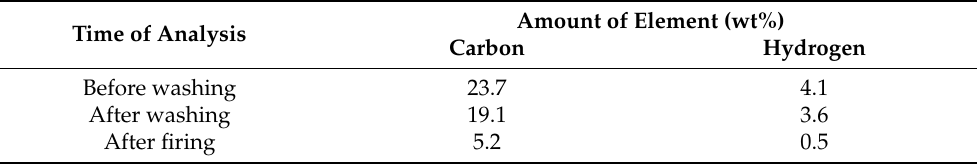
Amount of Element (wt%) Carbon